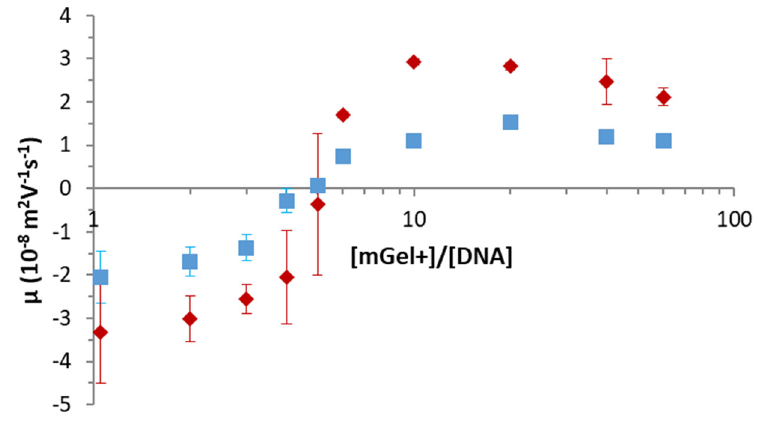
Figure 3. Electrophoretic mobility of DNA/mGel+ complexes at different [DNA]/[mGel+] concen- tration ratios for swollen (20 °C, blue squares) and shrunken (50 °C, red rhomboids) microgels. The concentration of DNA is fixed at 0.025 g L − 1 and the concentration of mGel+ varies between 0.025 and 1.5 g L − 1 . Values plotted are the mean of three independent measurements with standard deviation.